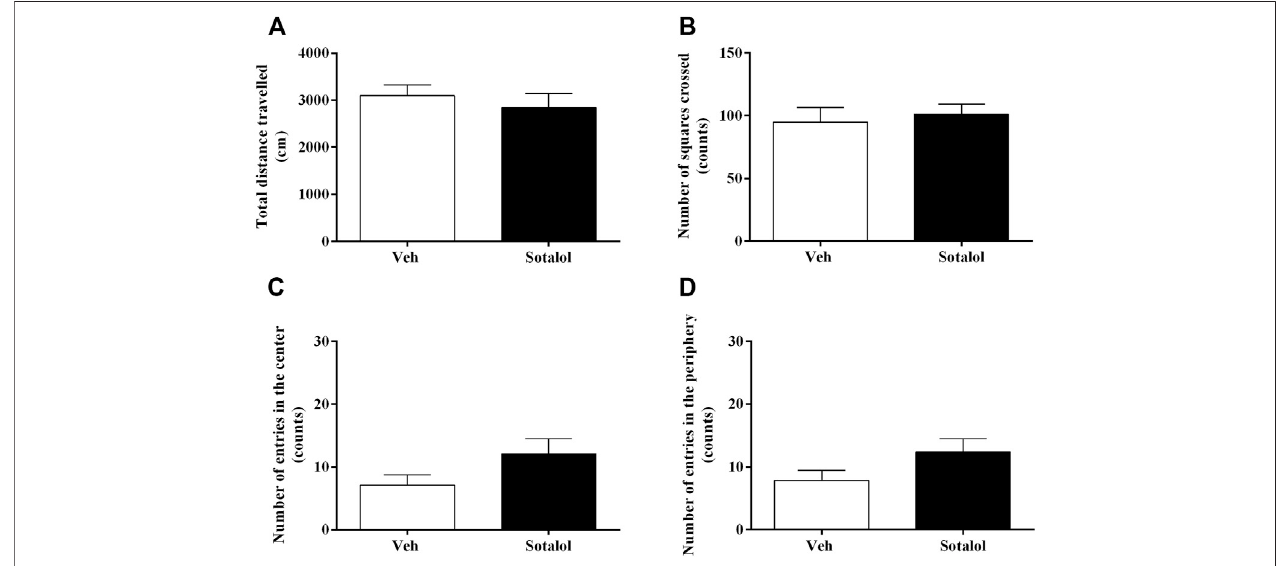
FIGURE5|(A) Totaldistancetravelled,andnumberof (B) squarescrossed, (C) entriesinthecenter,and (D) entriesintheperiphery intheopen fi eldtest(OFT),on day 17 after post-traumatic stress disorder (PTSD) induction. Veh, vehicle-treated PTSD mice; Sotalol, sotalol-treatedPTSD mice.Values are means ± SEM of 6-7mice per group.